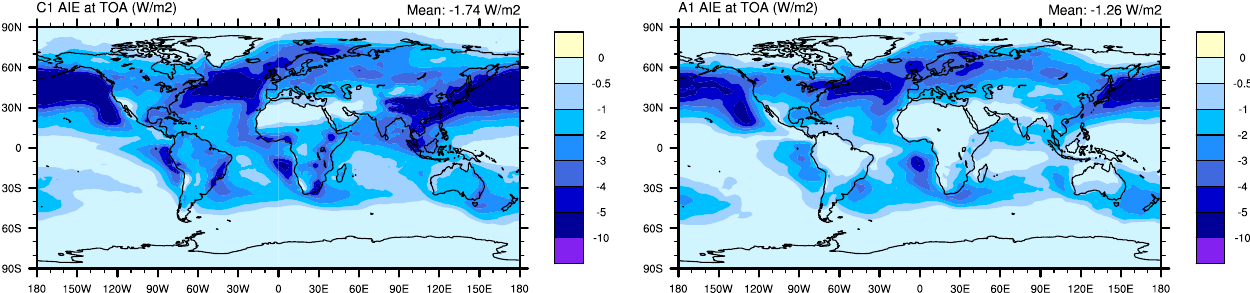
Fig. 13. First aerosol indirect effect (AIE) from case C1 (left) and A1